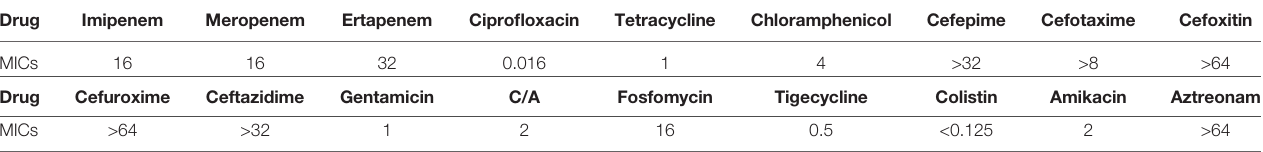
TABLE 1 | MICs for ZJ27003 of carbapenems and other